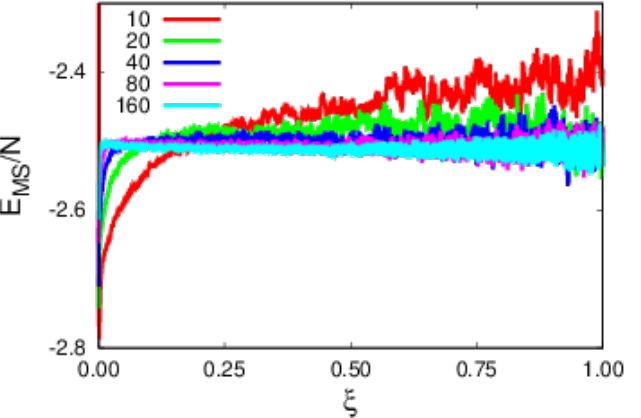
Figure 4. Fraction of surviving samples as a function of rescaled time, ξ , for polymers of various sizes.